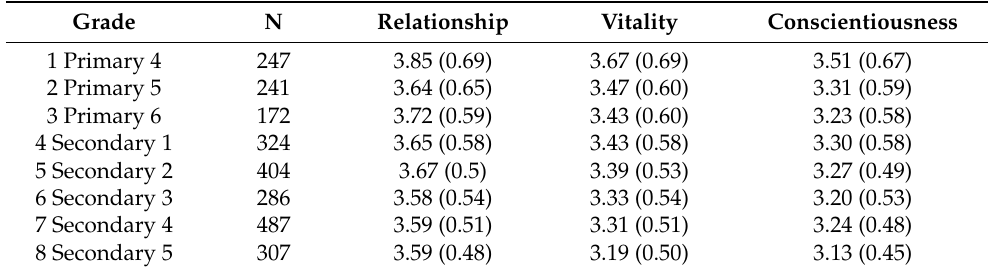
Table 2. Means and Standardization for Chinese Virtues Questionnaire by Grade.